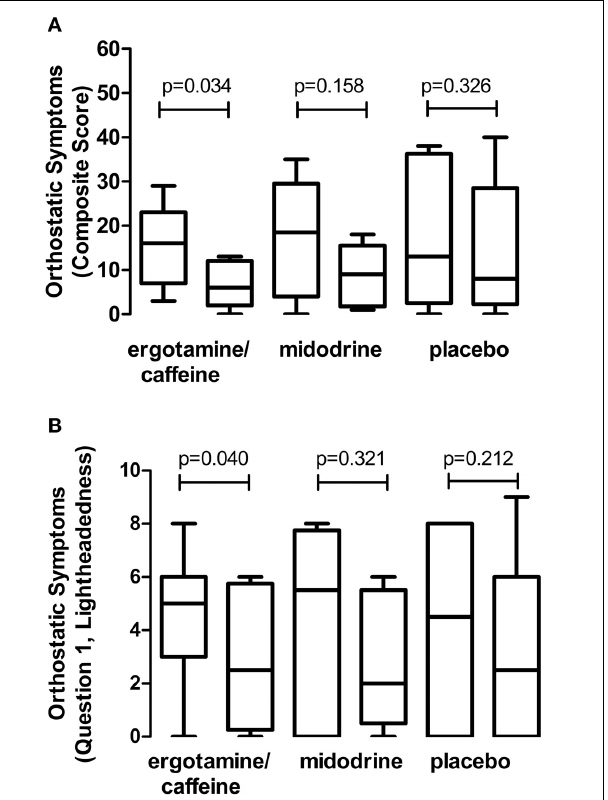
FIGURE 3 | Effect of drugs on orthostatic presyncopal symptoms. Data represent changes in orthostatic symptom scores from baseline (left bar) to 60min post-administration (right bar), with comparisons made for each individual drug. (A) Combination 1mg ergotamine and 100mg caffeine reduced the orthostatic symptom composite score in autonomic failure patients, suggesting an improvement in presyncopal symptom burden. In contrast, there was no effect of 5–10mg midodrine or placebo on this composite score. (B) Combination ergotamine and caffeine also reduced the lightheadedness component (Question 1) of the orthostatic symptoms score in these patients, with no significant effect of midodrine or placebo. Data are presented as mean ± 95% confidence